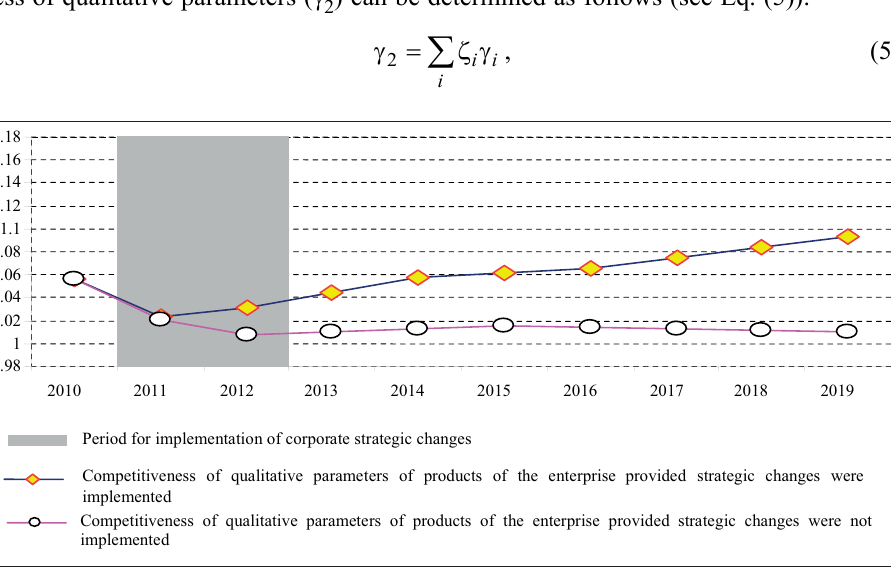
) of qualitative parameters 2